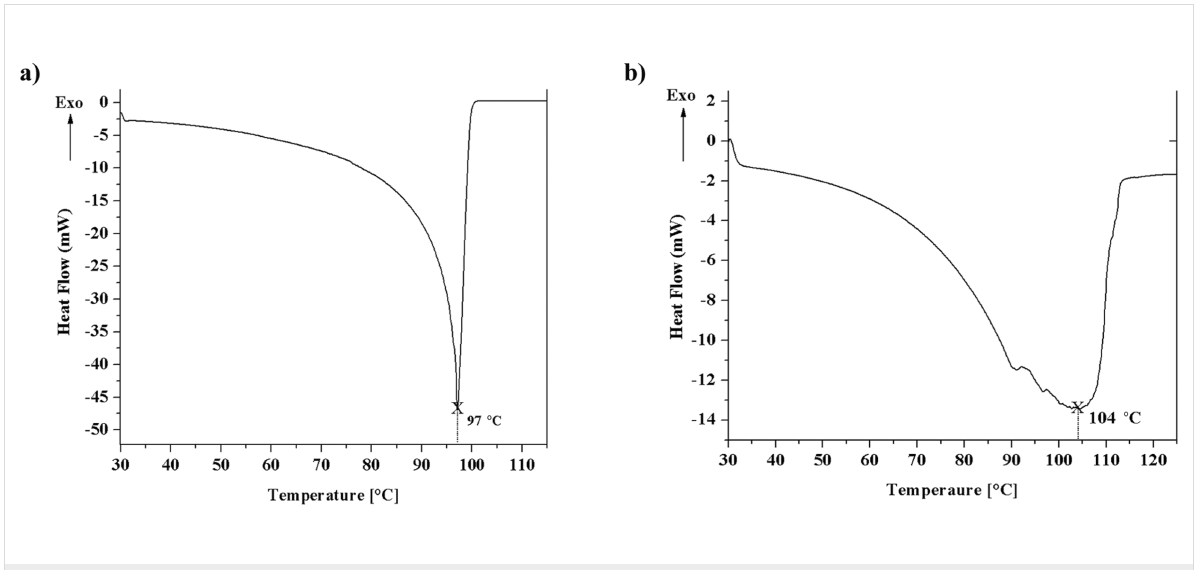
Figure 3: DSC thermograms of gels prepared from TPM-G12 in (a) Propan-1-ol and (b) DMSO.